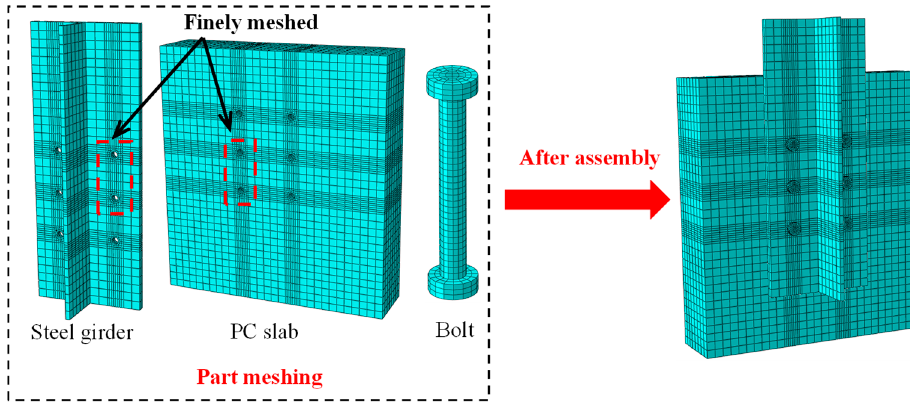
Figure 4. Mesh details of the FE models.